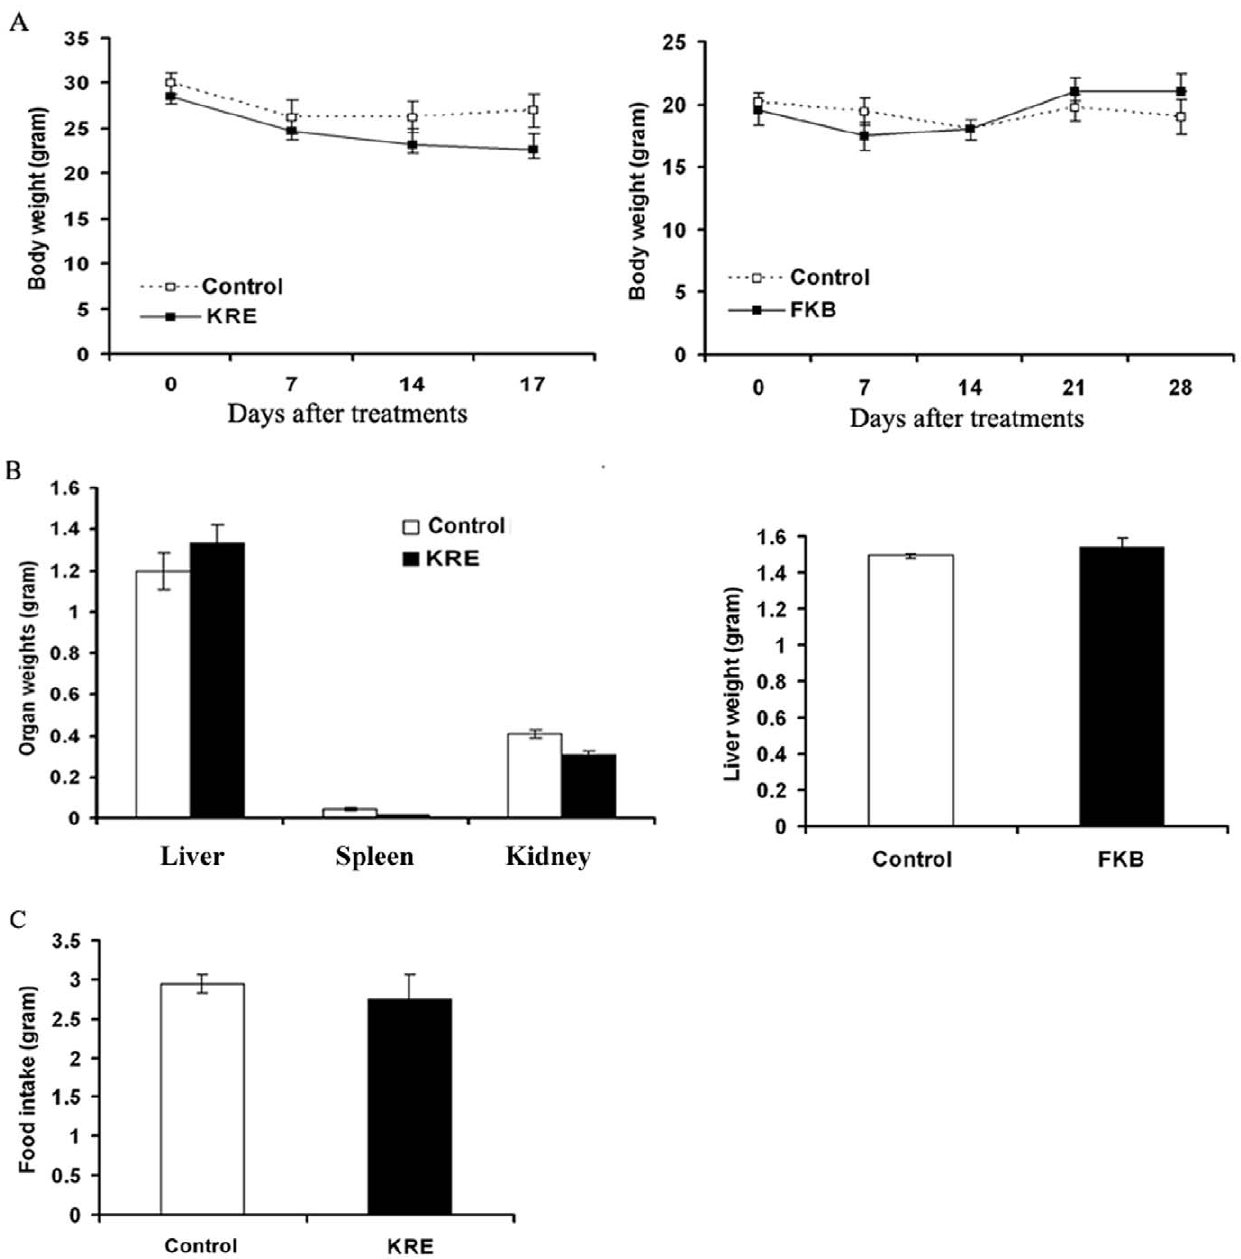
Figure 8. The effect of the kava root extract and FKB on mouse body and organ weight and food intake. (A). Body weights of vehicle, the kava root extract, and FKB treated SCID mice were recorded weekly and presented as mean 6 SD. (B). Organ weights of vehicle, the kava root extract, and FKB treated SCID mice at the end of the experiments were recoded and presented as mean 6 SD. (C). Food intakes of vehicle and the kava root extract treated SCID mice were recorded weekly and presented as mean 6 SD.